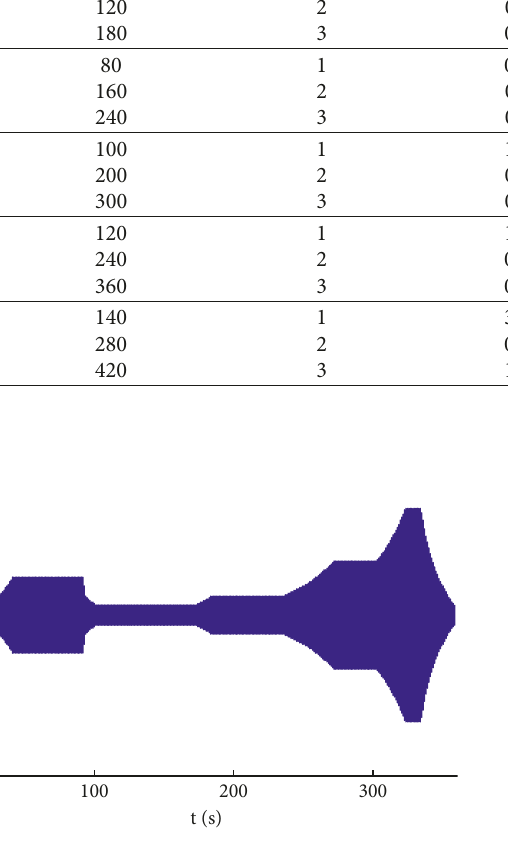
Figure 10: The curve of the simulated reference signal.